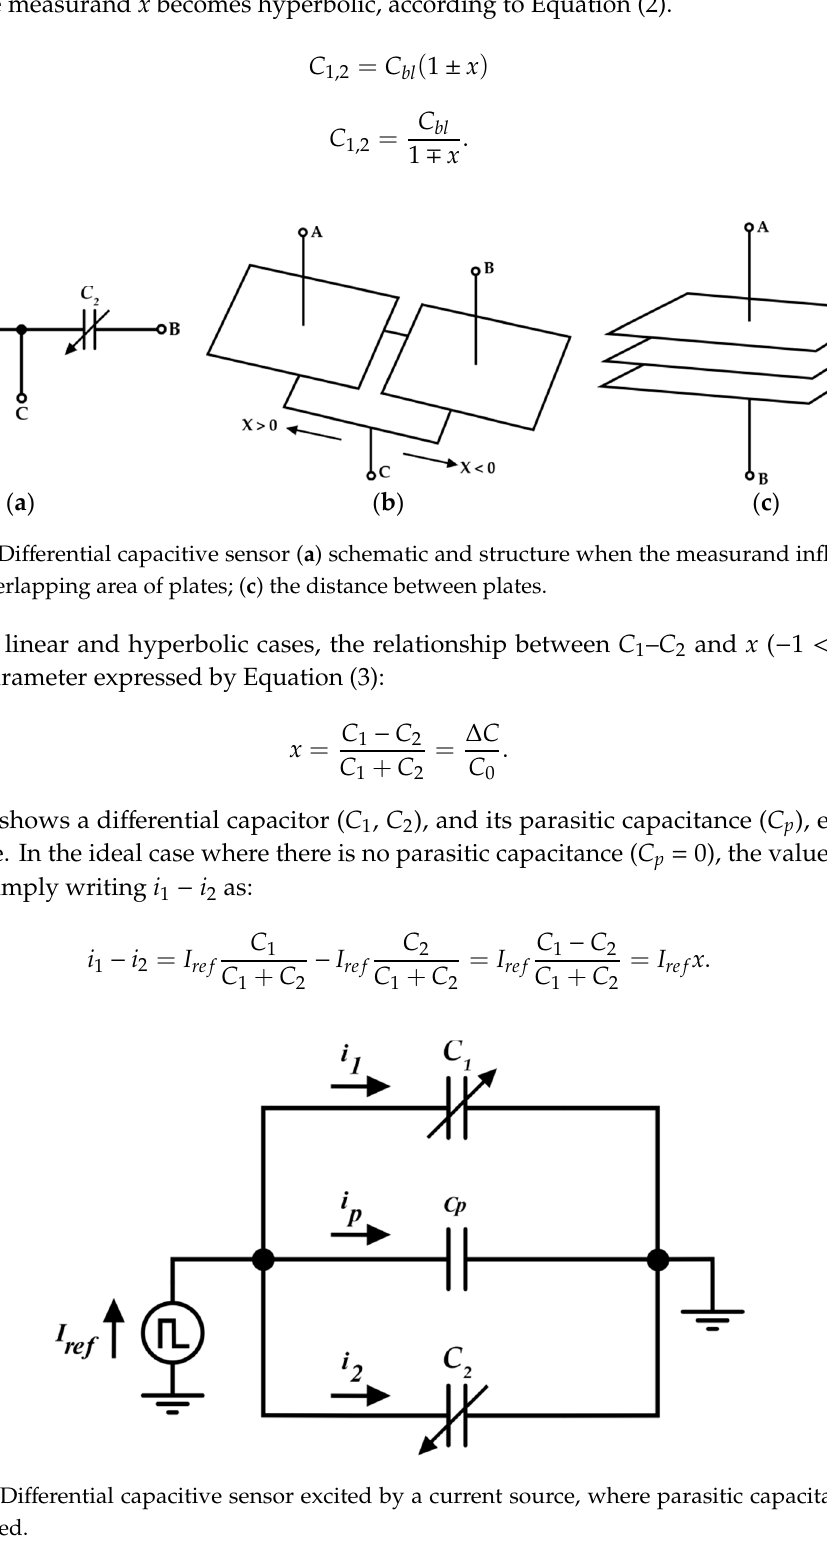
Figure 2. Differential capacitive sensor excited by a current source, where parasitic capacitance C p is evidenced.